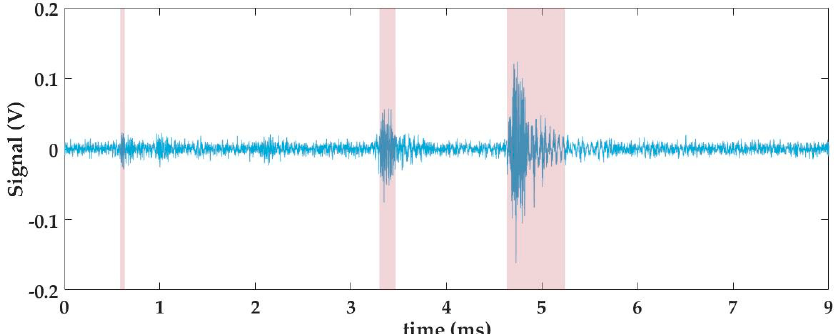
Figure 2. Fragment of the recorded signal where dielectric degradation occurred.